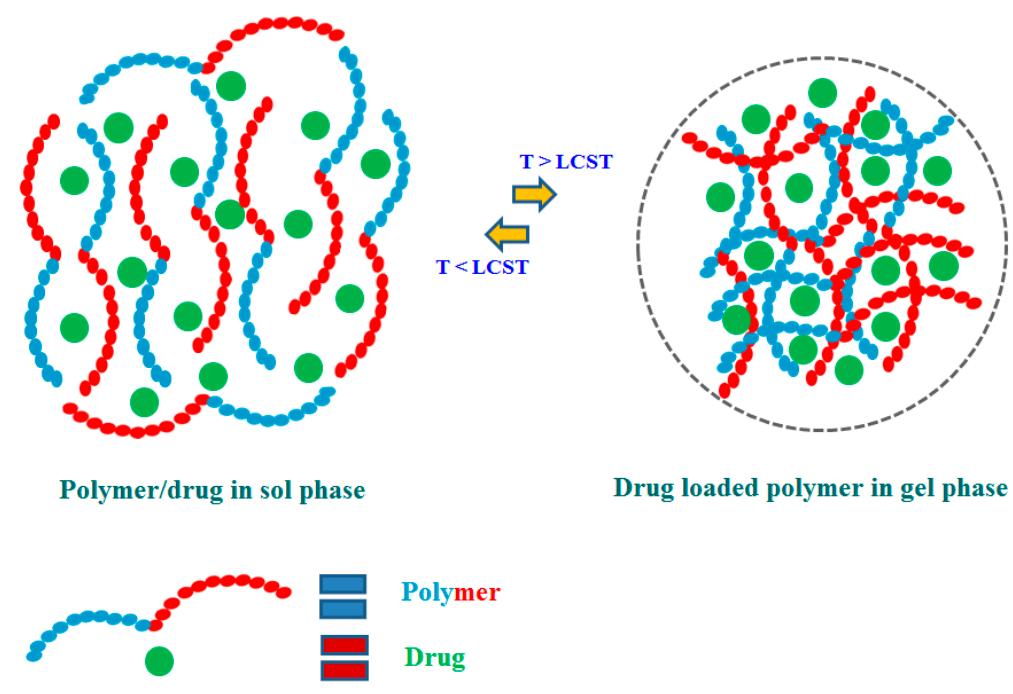
Figure 1. The schematic representation of thermo-responsive behavior (LCST) of the stimuli-responsive polymer hydrogel drug delivery system.